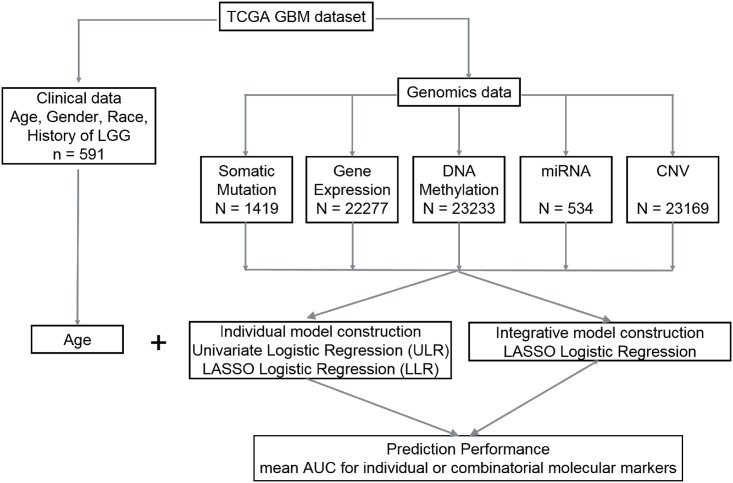
Flow chart with a schematic of the data analysis pipeline used in this study.